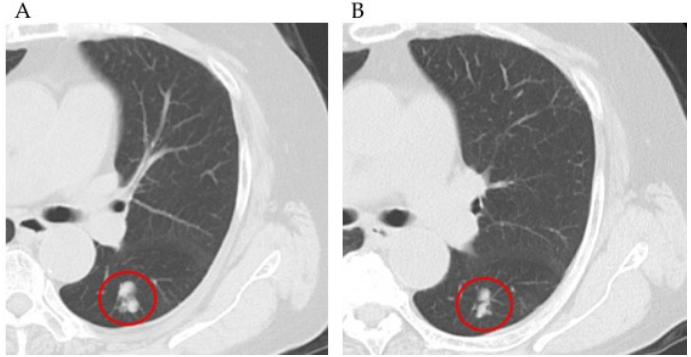
Figure 3. ( A ) Chest computed tomography showing a lung metastatic lesion before everolimus treatment. ( B ) Chest computed tomography showing a lung metastatic lesion after treatment with everolimus, end of 1 month, with decreased size.